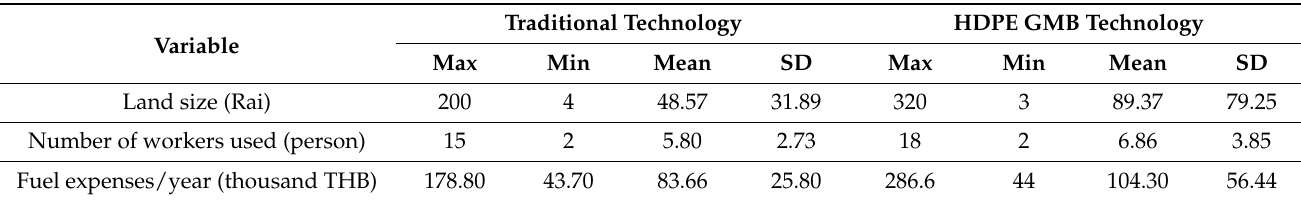
Table 2. Descriptive statistics of farm input variable utilization by group.